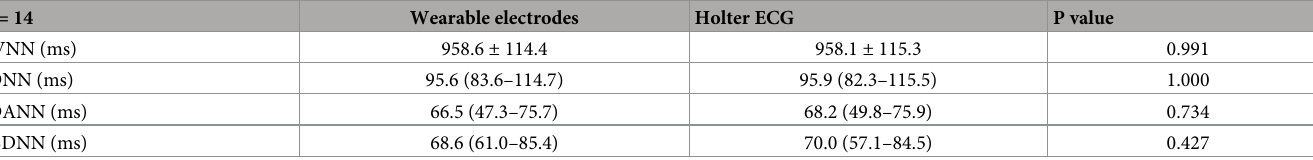
Table 4. Time-domain analysis of heart rate variability between wearable electrodes embedded in undershirts and Holter ECG. N =